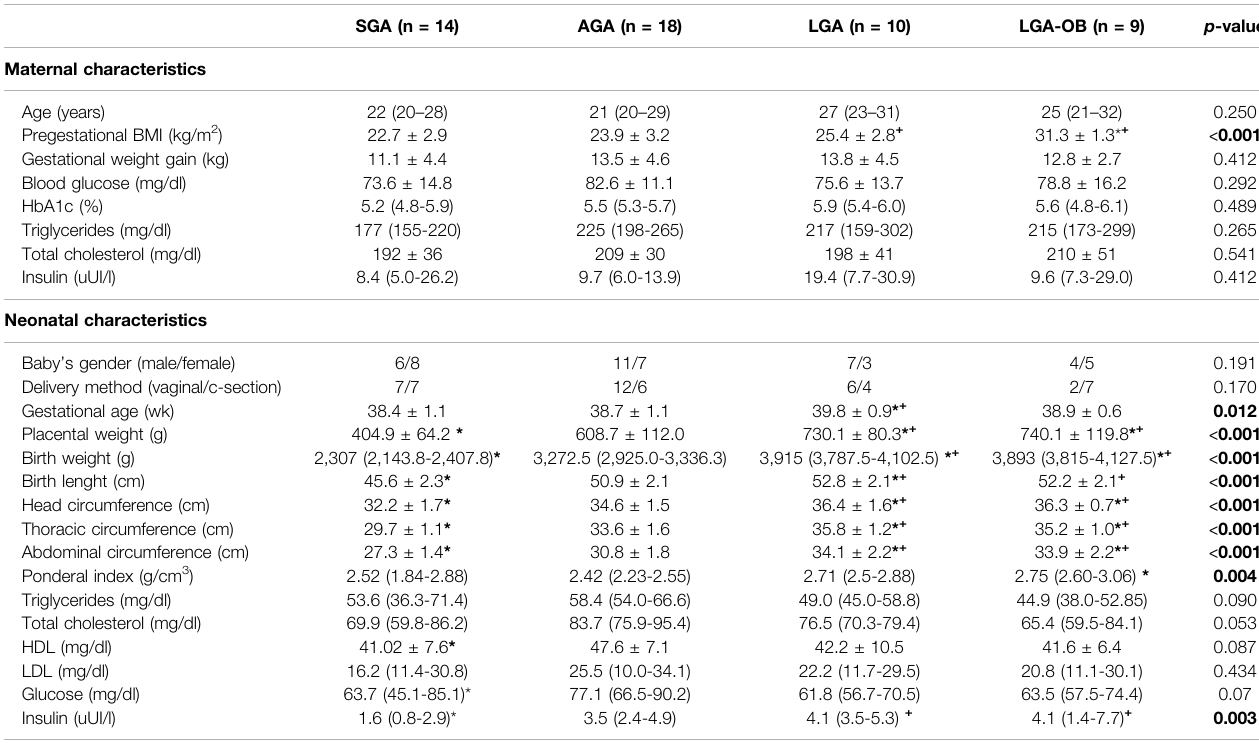
TABLE 1 | Clinical, biochemical, and anthropometric characteristics of mothers and their SGA, AGA, and LGA